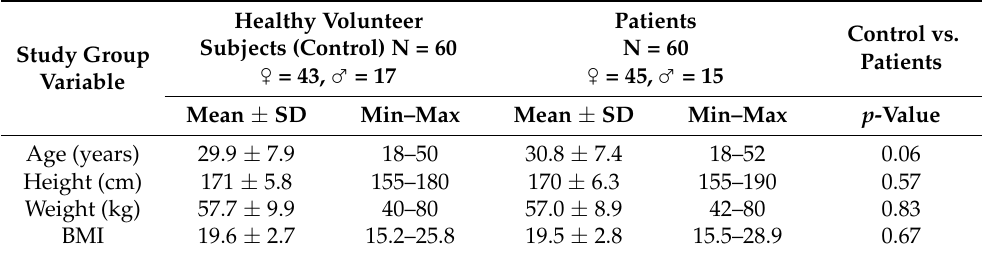
Table 1. The characteristics of the subjects enrolled in the